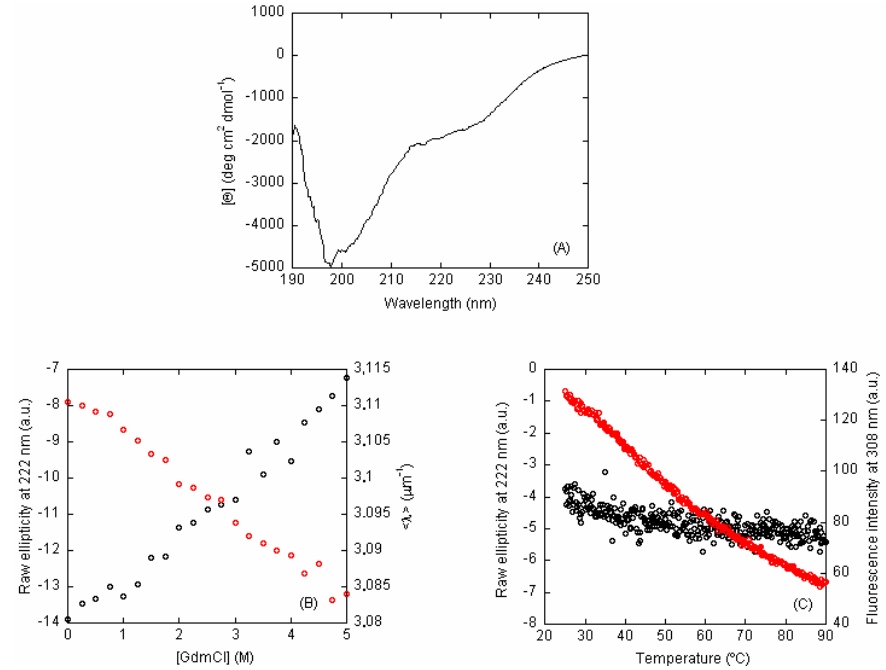
Figure 2. Spectroscopic characterization of C-LrtA: ( A ) Far-UV circular dichroism (CD) spectrum of C-LrtA. Spectrum was acquired at 20 °C, and pH 7.2 (50 mM, Tris buffer) with 20 μ M (in protomer units) of protein concentration; ( B ) GdmCl-denaturations of C-LrtA followed by fluorescence (right axis, red circles) and CD (left axis, black circles), at 10 μ M of protein concentration (in protomer units) and 20 °C; ( C ) Thermal denaturations of C-LrtA followed by fluorescence (right axis, red circles) and CD (left axis, black circles). Experiments were acquired at pH 7.2 (50 mM, Tris buffer) and 10 μ M of protein concentration (in protomer units). The ellipticity (far-UV CD) units of thermal denaturations are arbitrary, because values are scaled up.